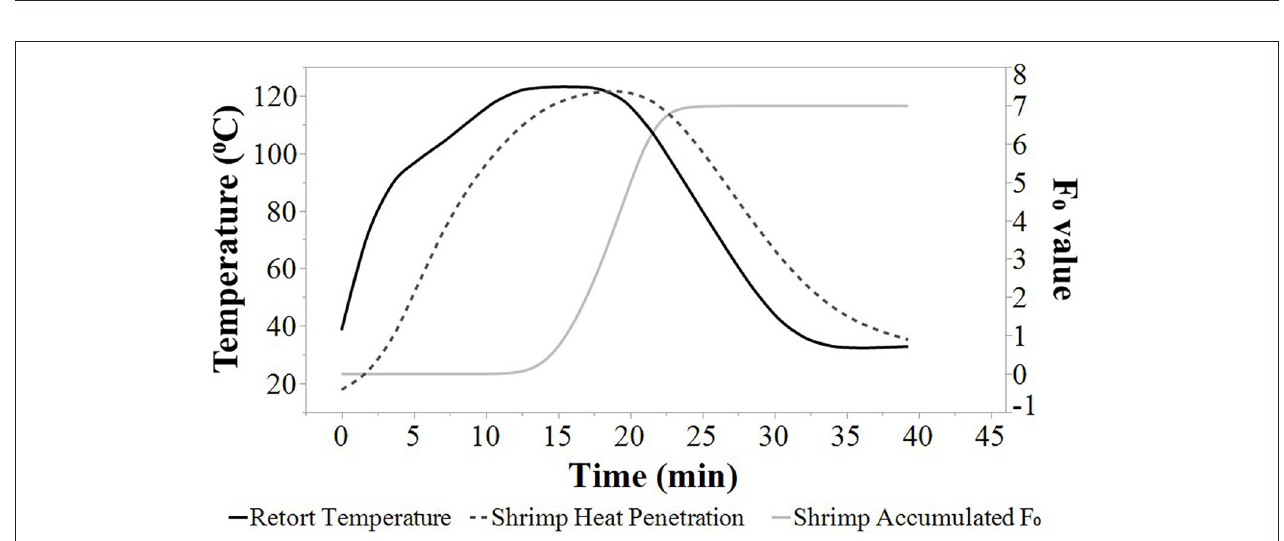
FIGURE 2 | Average retort temperatures (solid black), heat penetration curves (dotted black), and accumulated F 0 (solid gray) values for Louisiana Gulf Coast (LGC) brown shrimp during retort thermal processing at 45 SPM. JMP smoother function was used to construct all figure lines.